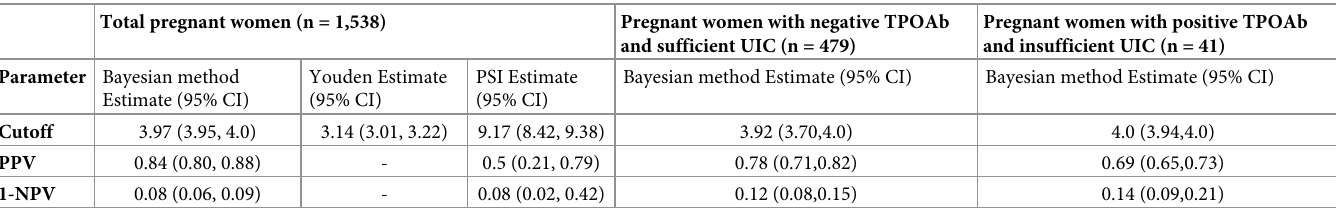
Table 2. Cutoff, PPV and 1-NPV estimated by Bayesian and frequentist approaches with 95% credible/confidence intervals.